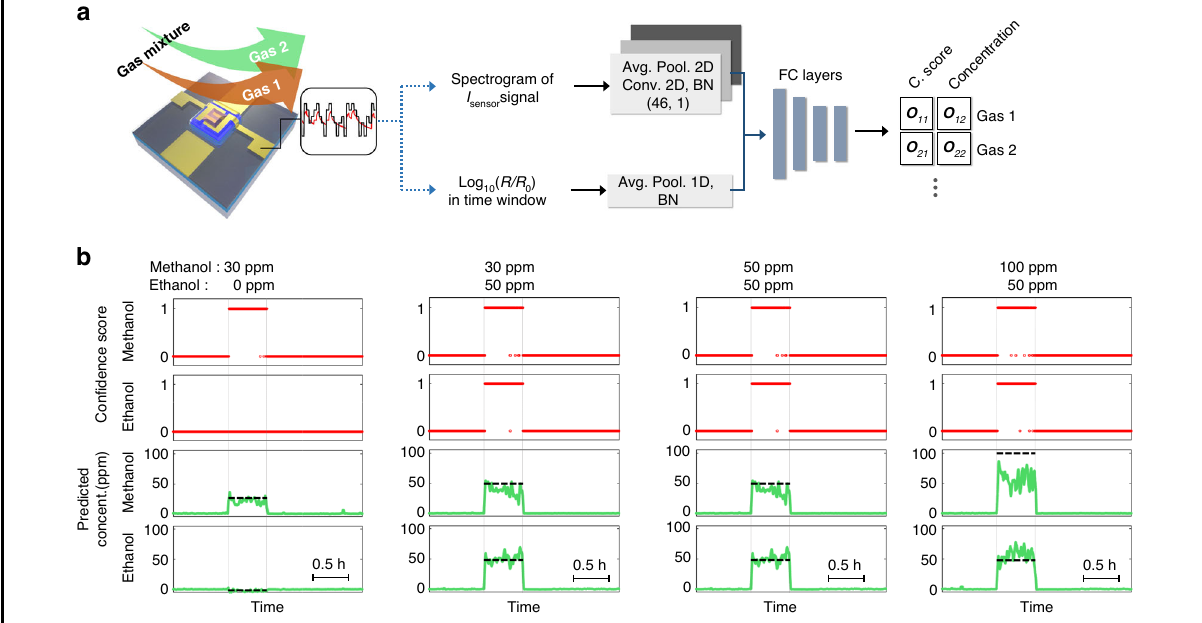
Fig. 4 Identi fi cation of binary gas mixture. a Architecture of modi fi ed deep convolutional neural network for identifying gas mixtures. The network output is the normalized concentration of each gas and its con fi dence score (C. score). The length of the output tensor is expandable according to the appropriate target environments. b Real-time identi fi cation of gas mixture with various mixing ratios of methanol (0, 30, 50, 100 ppm) and ethanol (0, 30, 50, 100 ppm). The binary C. score (0 and 1) indicates the existence of a speci fi c gas, 1 and 0 representing the presence and absence of the gas, respectively. The result shows accurate identi fi cation of gas mixture as well as estimation of gas concentrations of both